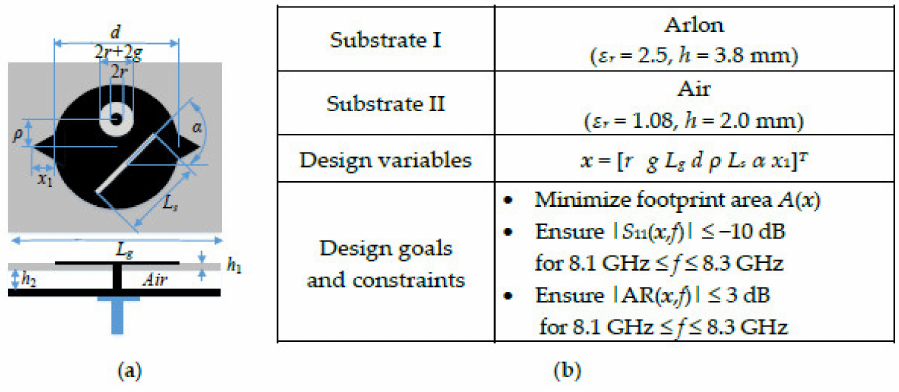
Figure 6. Circular patch antenna [56]: ( a ) geometry, ( b ) essential parameters. Table 2 shows the optimization results: the antenna footprint, as well as violations of both constraints ζ AR and ζ S 11 , imposed on axial ratio and reflection, respectively. Figure 7 shows the antenna outputs, along with the evolution of penalty factors throughout the optimization run. Similarly, as for the algorithm described in Section 3.1, the considered procedure allows for obtaining enhanced miniaturization rates, and, at the same time, a better level of control over constraint violations has been achieved. Table 2. Optimization results for antenna of Figure 6. Algorithm